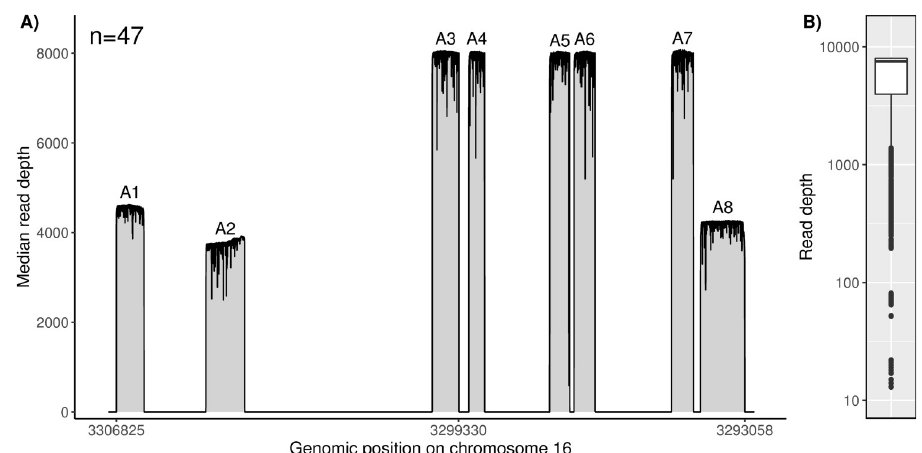
Fig 2. Visualization of the read depth distribution achieved by Nanopore sequencing. (A) Median read depth achieved by amplicon sequencing of selected regions in the MEFV gene in 47 clinical samples using a MinION sequencing device. The target regions cover the relevant regions of all 10 exons of this gene. (B) Read depth distribution in the target regions over all 47 samples. A median read depth of 7565x (IQR 4025) was achieved. Outliers with a reduced sequencing depth were observed at the edges of individual